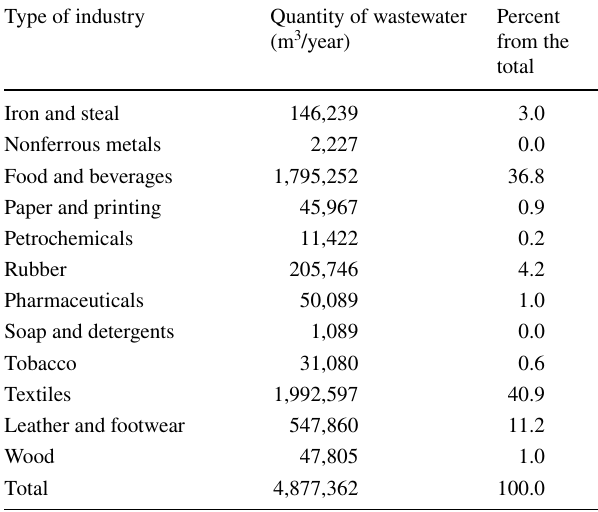
Table 1 A table that describes the level of industrial pollution that is created on the Addis Ababa Rivers Source Leta et al. (2016) Type of